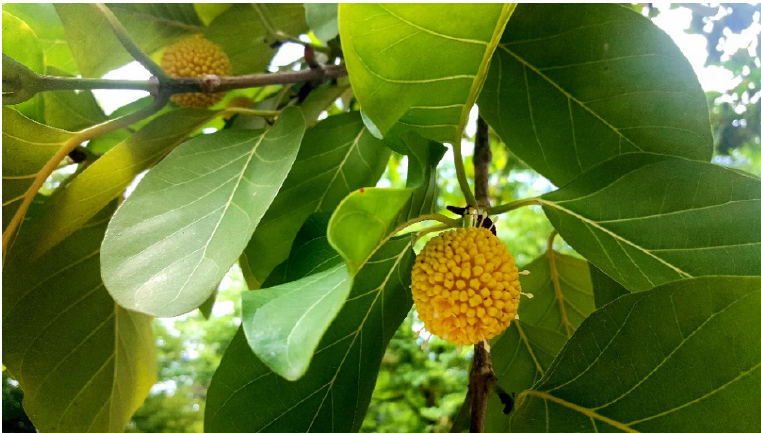
Figure 1. Leaves and fruits of Nauclea orientalis . Photo: W.